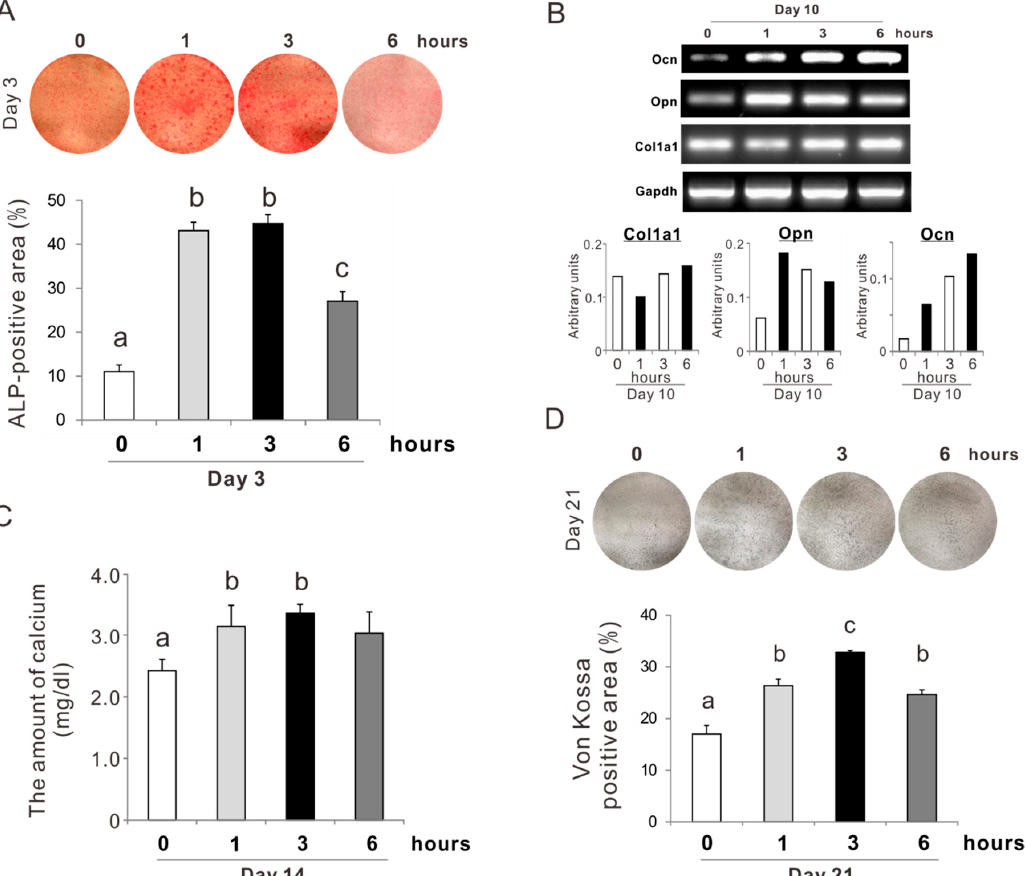
Figure 6. Effects of preconditioning osteoblast-like cells with N -acetyl- L -cysteine (NAC) on osteogenic differentiation. Rat femur bone marrow-derived osteoblast-like cells were preincubated with or without 5 mM NAC for 1, 3, and 6 h and then cultured in an osteogenic differentiation medium without dexamethasone. ( A ) Alkaline phosphatase (ALP) activity was evaluated on day 3 culture with an azo-dye staining. The upper and lower panels in (A) are the representative images of stained cultures and the histogram of the percentage of ALP-positive area relative to total cell growth area on a culture well, respectively. ( B ) Gene expressions of bone tissue-related extracellular matrix such as pro-alpha1 chains of type I collagen ( col1a1 ), osteopontin ( opn ), and osteocalcin ( ocn ) with glyceraldehyde-3-phosphate dehydrogenase ( gapdh ) as a house-keeping gene were evaluated on day 10 of culture with reverse transcription polymerase chain reaction. Upper and lower panels in (B) are the representative PCR bands visualized with ethidium bromide staining and the histogram of the expression levels of each gene standardized by gapdh expression. Matrix mineralization was evaluated on days 14 and 21 with a titration calorimetry for calcium ions extracted from the cultured extracellular matrix ( C ) and Von Kossa staining ( D ), respectively. The upper and lower panels in (D) are the representative images of stained cultures and the histogram of the percentage of the Von Kossa-positive area relative to total cell growth area on a culture well, respectively. The data represent the mean ± standard deviation ( n = 3). Di ff erent characters indicate statistically significant di ff erences between them ( p < 0.05, Tukey’s HSD